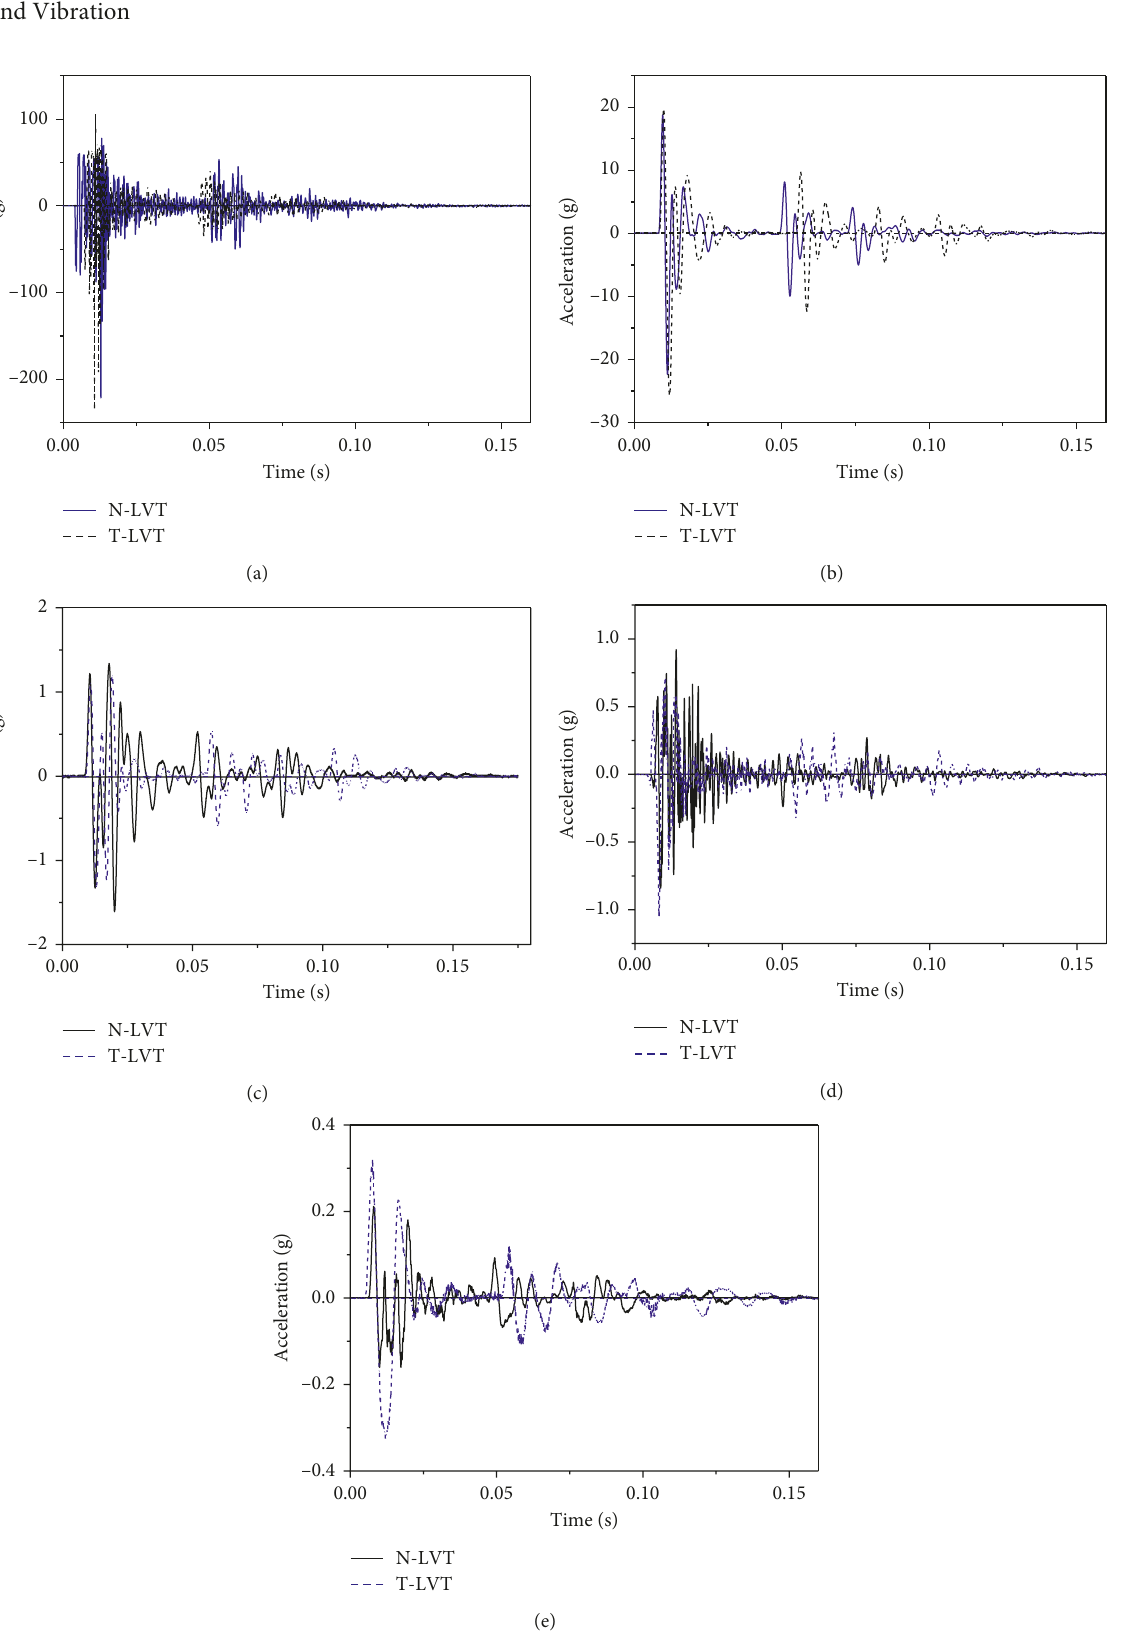
Figure 12: Comparison of vertical time-history curve of the track components. (a) Rail. (b) Bearing block. (c) Track slab. (d) Foundation base. (e)